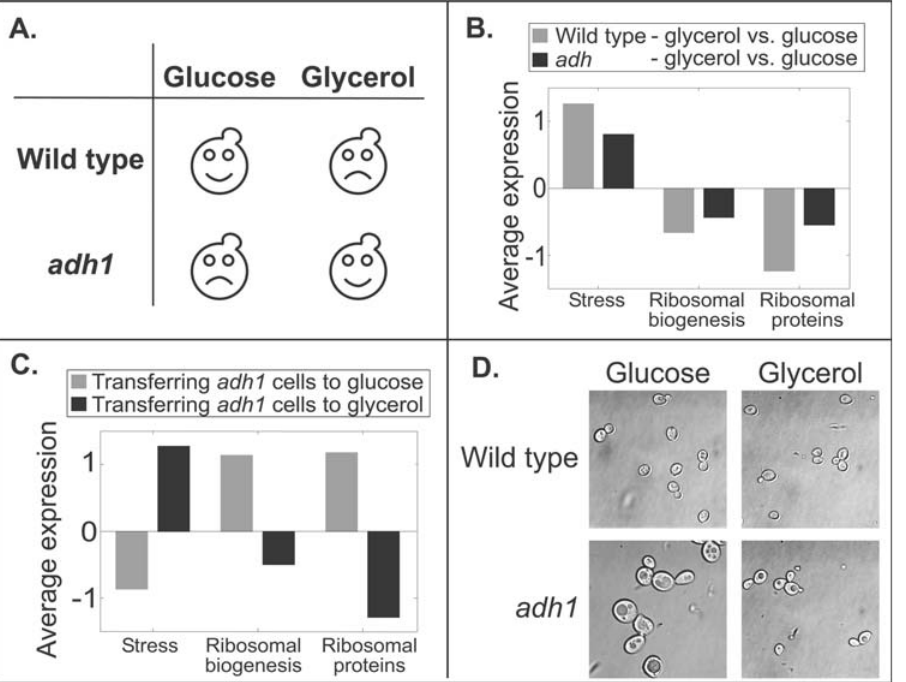
Figure 2. Ribosomal gene expression under ‘‘confusing’’ conditions. (a) Glucose is the preferred carbon source for wild-type yeast cells. In contrast, adh1 mutant cells grow faster when glycerol is available (See also Fig S1). (b) Wild-type and mutant cells were grown to log phase on media containing glucose or glycerol as the only carbon source (Methods). The expression profile on glycerol vs. glucose was quantified with microarrays. The bars represent the average log 2 -ratio-expression of the ESR modules. Notably, both wild type and mutant cells activate the ESR program. Stress genes are induced while ribosomal biogenesis genes and RP are repressed. (c) Response of adh1 mutants to change in carbon source. Overnight cultures of adh1 cells were transferred both to glycerol and to fresh glucose media. The bars represent the average expression after 30 minutes with respect to the initial cell culture expression (log 2 -ratios). As expected, the ESR is repressed upon transfer to fresh glucose medium. However, upon transfer to glycerol, the favorable carbon source of these mutant cells, the ESR is activated. Specifically, stress genes are induced while ribosomal biogenesis and RP genes are repressed. (d) Wild-type and adh1 mutant cells were monitored upon transfer to glycerol versus their transfer to fresh glucose. As previously reported, the size of slow growing wild type cells (glycerol) is smaller than fast growing ones (glucose) [26]. Interestingly, adh1 mutants display an opposite behavior. Specifically, slow growing adh1 mutants (glucose) are appreciably larger than the fast growing ones (glycerol). Thus, it appears that the cell size may also be tuned to the environmental signals rather than to cell